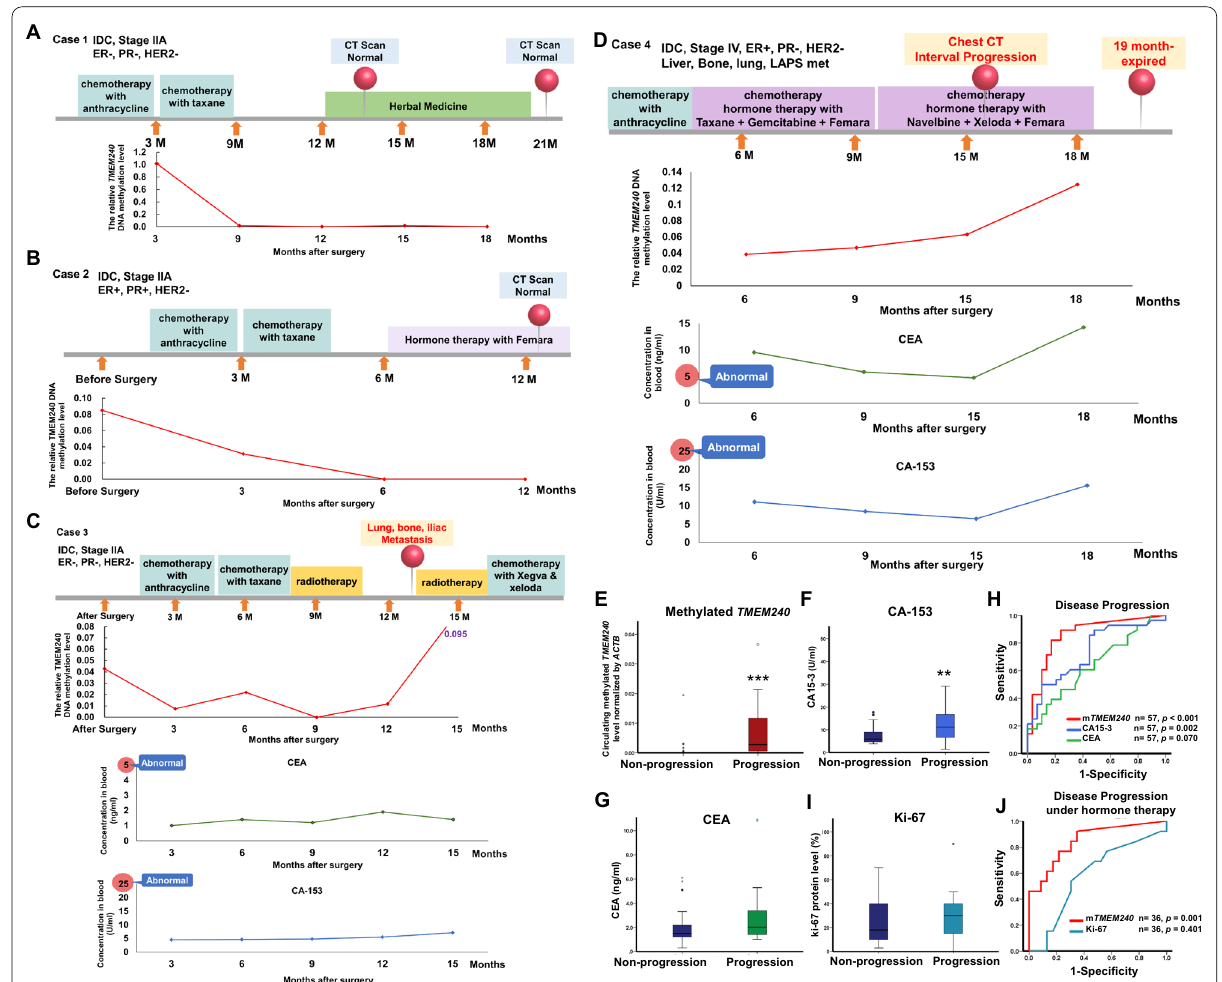
Fig. 5 Circulating methylated TMEM240 is increased in Taiwanese breast cancer patients with disease progression and poor hormone therapy response. The level of circulating methylated TMEM240 dramatically and gradually decreased in triple‑negative breast cancer patients ( A ) and in breast cancer patients who received hormone therapy and did not experience recurrence or metastasis ( B ). C Recurrence and metastasis were detected in triple‑negative breast cancer patients when circulating methylated TMEM240 was found in such patients after treatment, and it thereafter increased again. The concentrations of CEA and CA15‑3 in serum remained normal. D The level of circulating methylated TMEM240 gradually increased in breast cancer patients with disease progression even after hormone therapy and chemotherapy. The concentrations of CEA and CA15‑3 in serum are incapable of early monitoring of disease progression and poor treatment response. E Box plot showing the levels of circulating methylated TMEM240 in the plasma of 32 patients with recurrence/metastasis and in the plasma of 29 patients without recurrence/ metastasis. F , G Box plots showing the concentrations of CEA and CA15‑3 in the sera of 28 patients with recurrence/metastasis and in the sera of 29 patients without recurrence/metastasis. ** P < 0.01; *** P < 0.001. H ROC curves for disease progression prediction were calculated using the measured circulating methylated TMEM240 levels and the measured concentrations of CEA and CA15‑3. I A box plot of the percentage of Ki‑67 expression level in breast cancer tumors from 13 patients with recurrence/metastasis and in tumors from 23 patients without recurrence/metastasis is shown. J ROC curves for disease progression and hormone therapy response prediction were calculated using circulating methylated TMEM240 levels and Ki‑67 expression